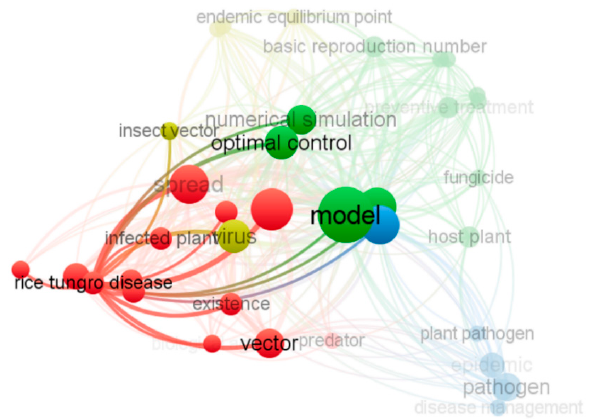
Figure 10. Mapping the topic of the spread of tungro disease in rice plants.